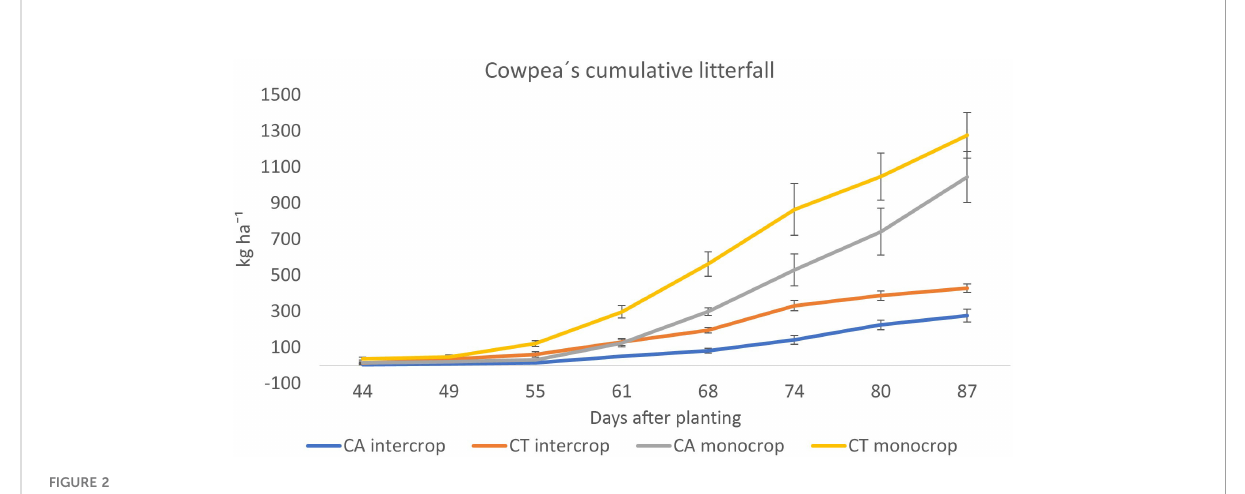
FIGURE 2 Cowpea ’ s cumulative litterfall across different cropping systems.